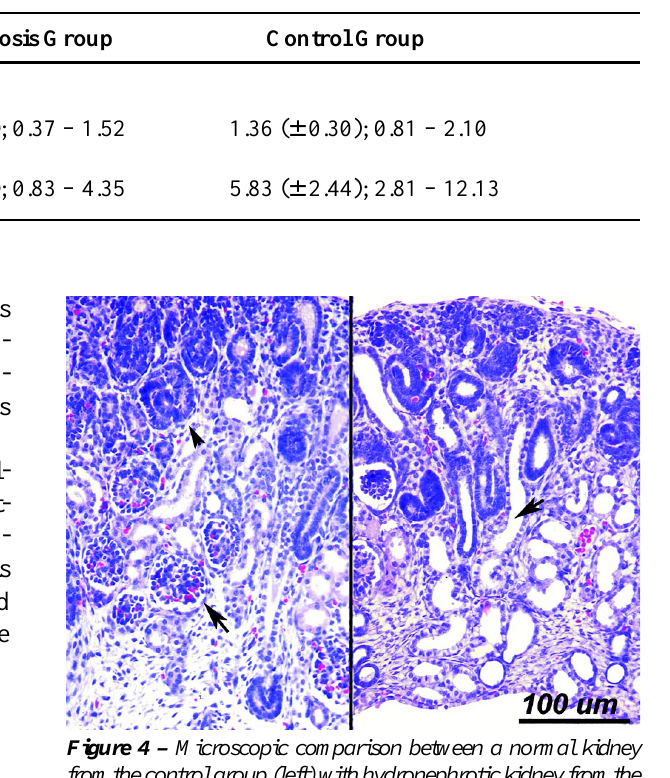
Table 3 – Comparison of histomorphometric measures. Mean, standard deviation and